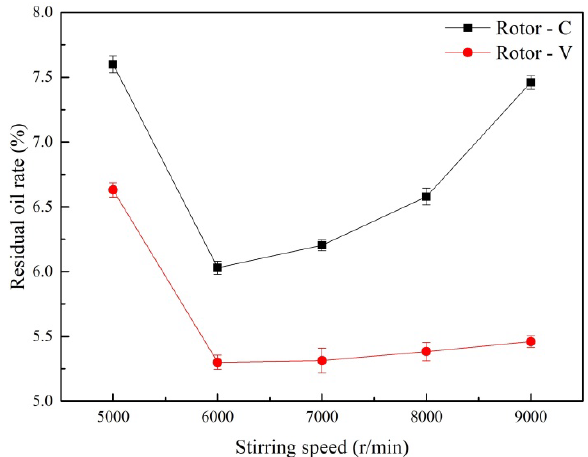
Figure 2. Effects of the stirring speed on the residual oil rate of the treated oily sludge.